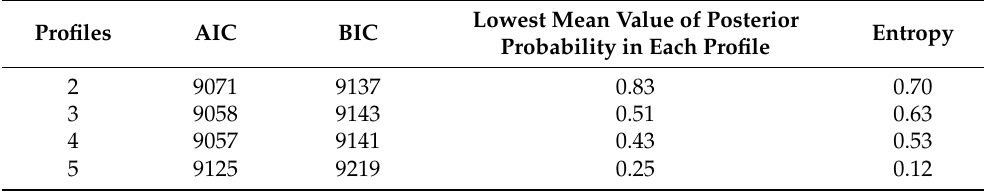
Table 1. Fit indices of the 2- to 5-profile latent class mixed models.